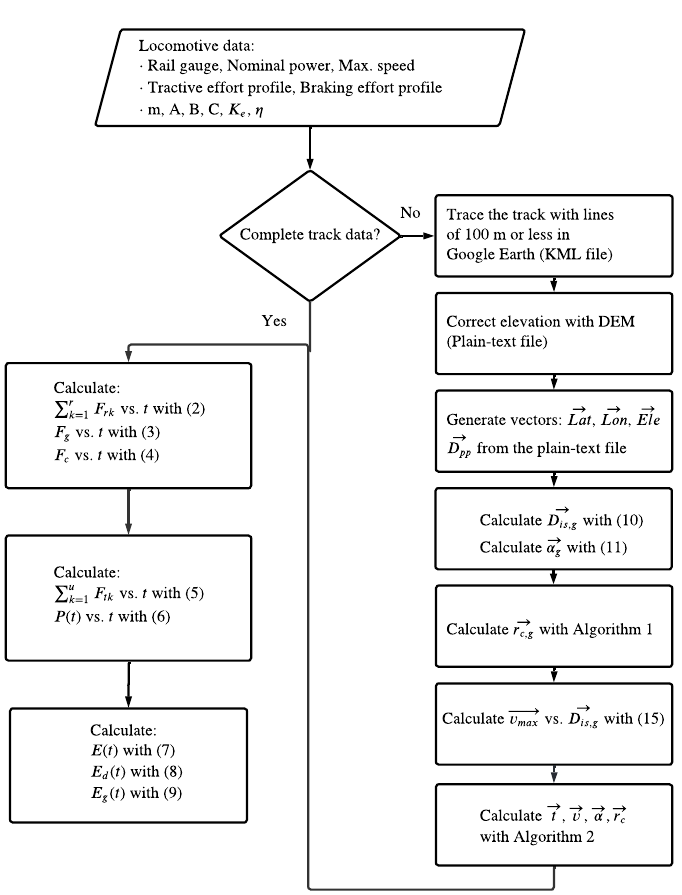
Figure 2. Flowchart of the proposed